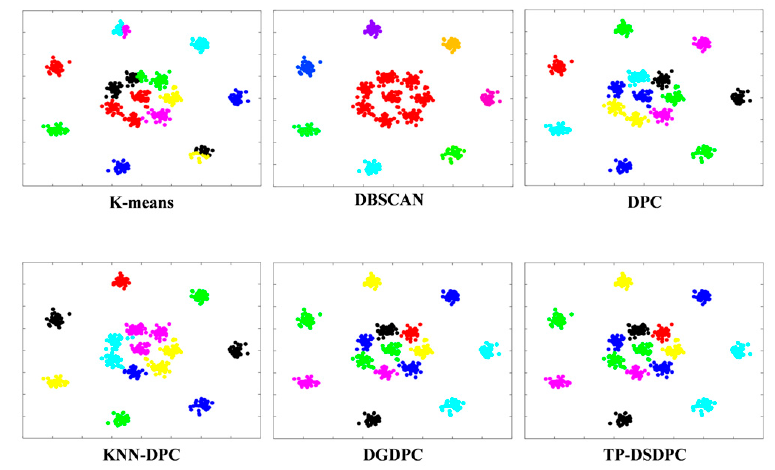
Figure 13. Clustering results on R15.